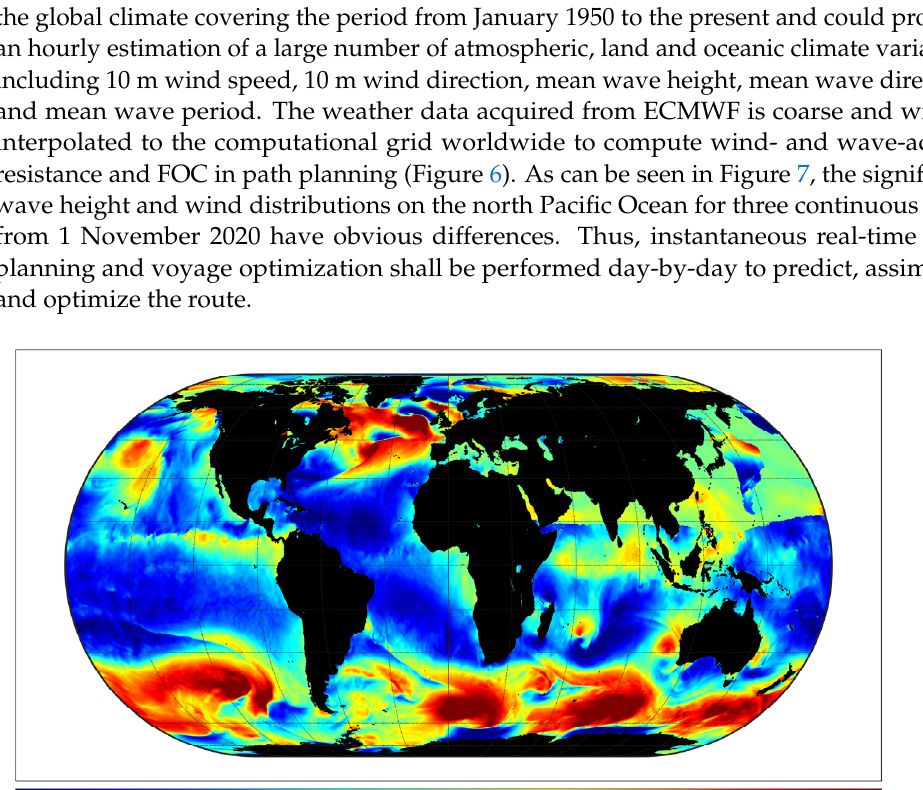
Figure 5. Geographic map and its computational grid for weather routing.